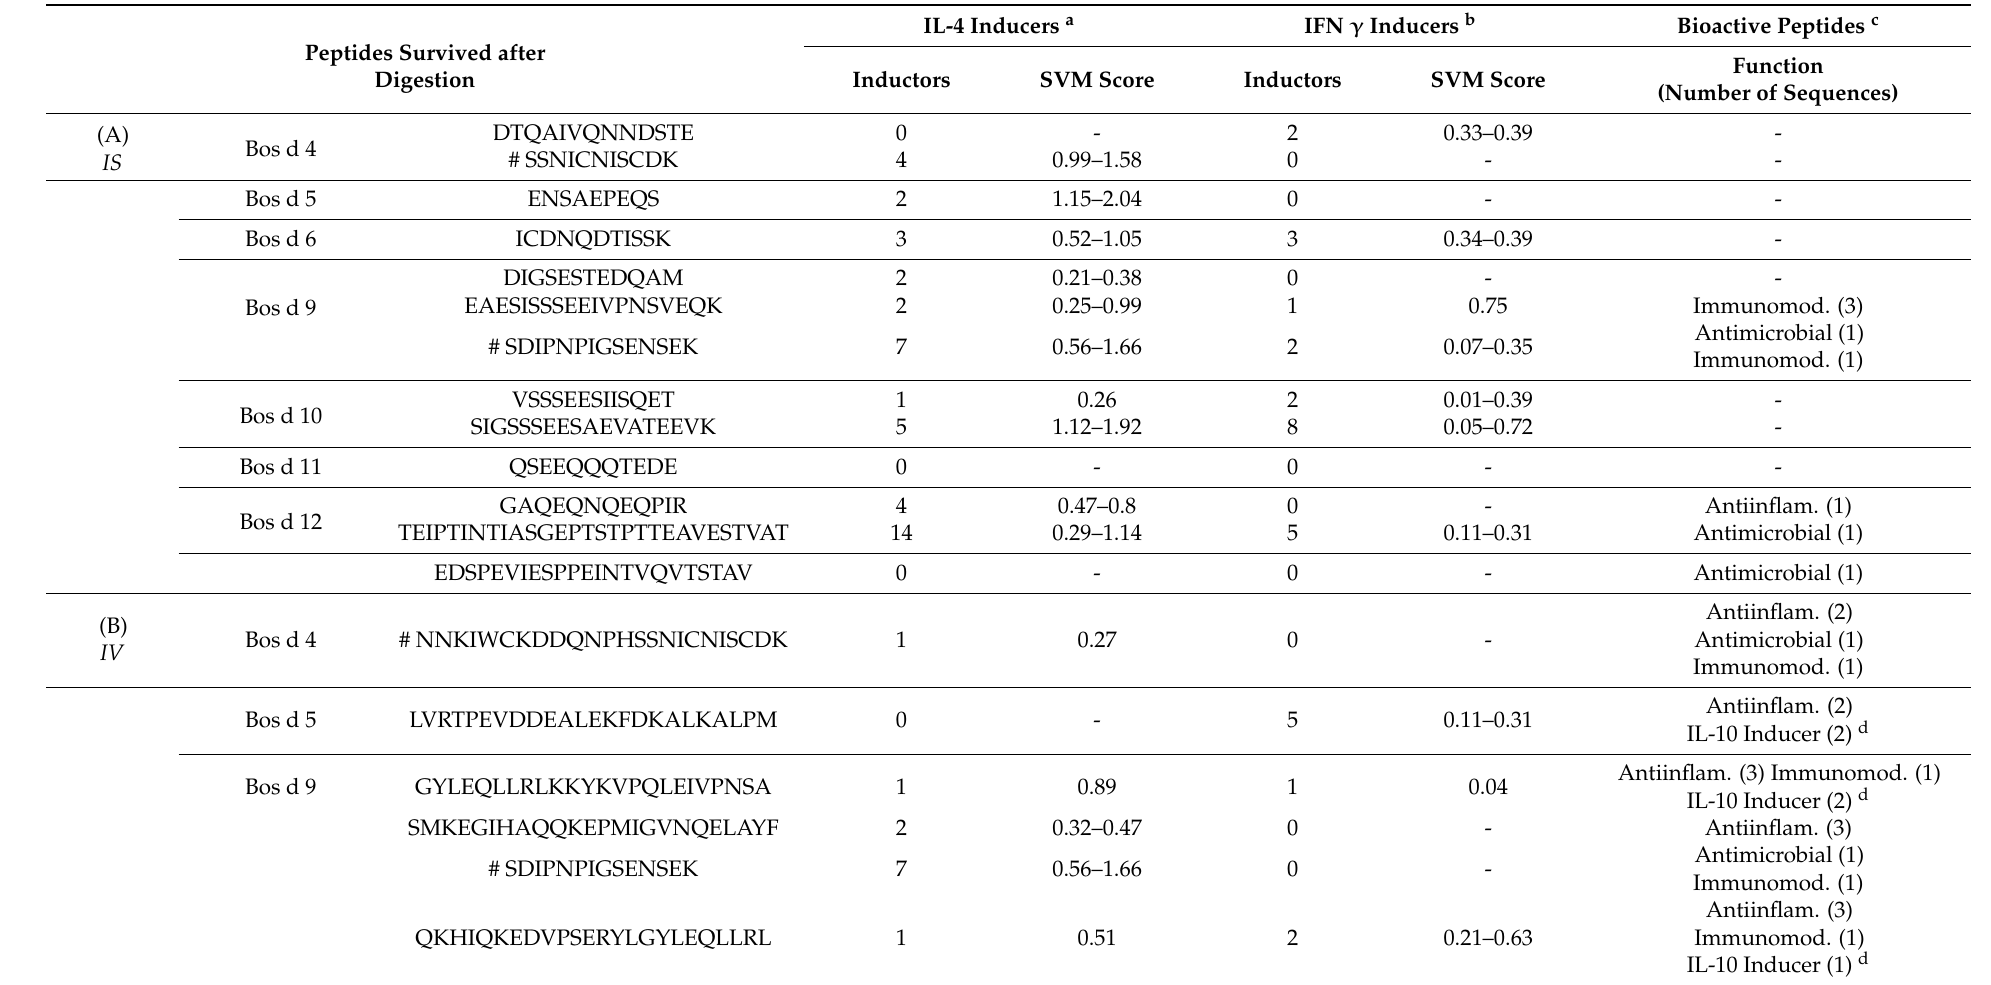
Table 5. Immunoreactive activities of